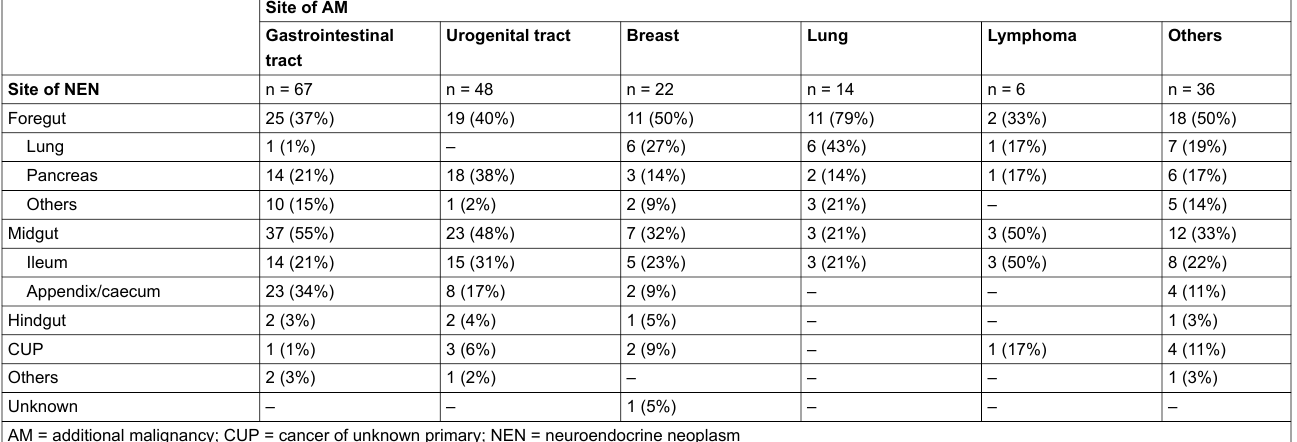
Table 3: Relation between the primary site of neuroendocrine malignancy and first additional malignancy.